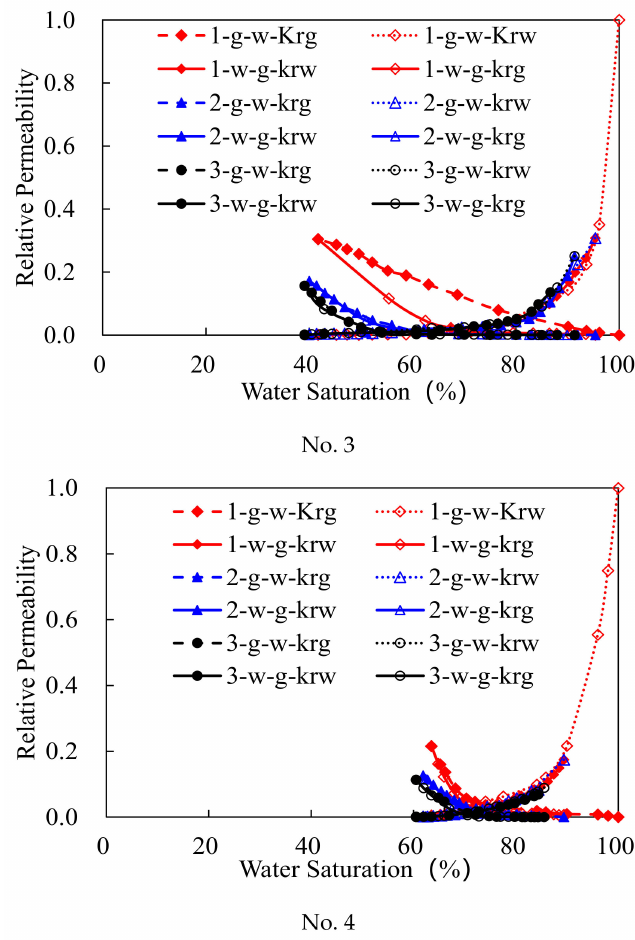
Figure 4. Characteristics of the multiwheel air–water interdrive penetration curves of cores No. 3 and 4. (1-g-o-K ro –1 represents turn; g-o represents gas flooding; K ro represents relative permeability of oil